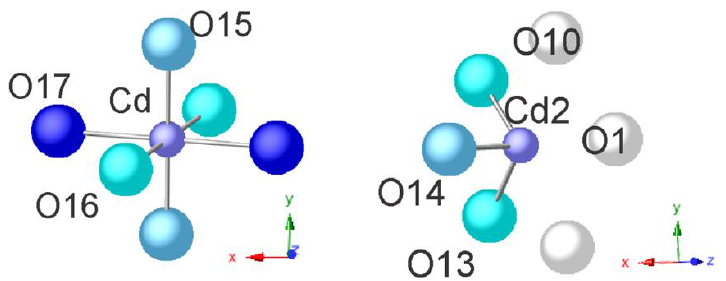
Figure 7. Coordination spheres of the cadmium positions Cd and Cd2 in the structure of Cd-clinoptilolite (90 °C, 22 days).